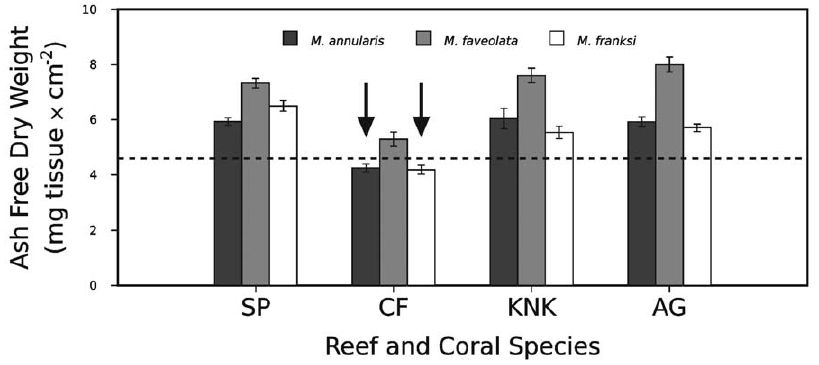
Figure 7. Tissue biomass of Montastraea spp. at 12–15 m depth in relation to colony mortality. A black arrow indicates that all coral colonies of that species and location died during the course of this study. Data presented as mean values of tissue biomass 6 standard error. Coral species identity indicated by bar color (see legend). Reef abbreviations provided in Fig. 1. Dashed line indicates the estimated threshold for mortality susceptibility (see text).